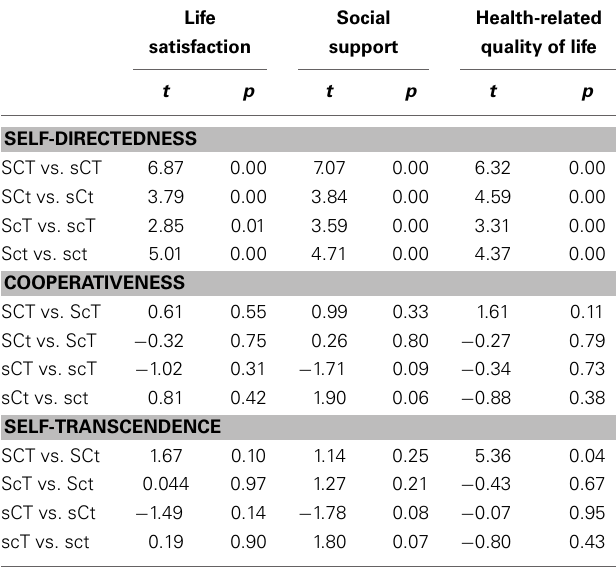
Table 5 | Comparisons between character profiles in standardized measures of well-being, social support and health-related quality of life. Life Social Health-related satisfaction support quality of life